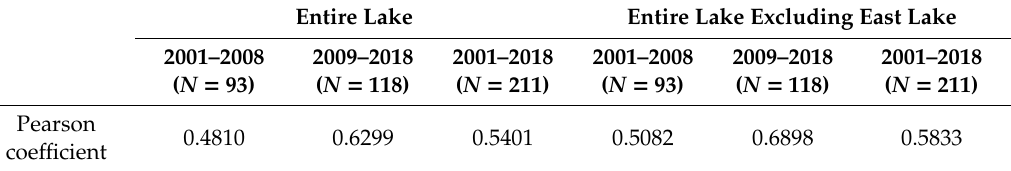
Table 2. Pearson correlation coefficients between monthly mean C Chla and monthly mean floating cyanobacteria area (FA m ) over entire lake and entire lake excluding East Lake, in different temporal stages.